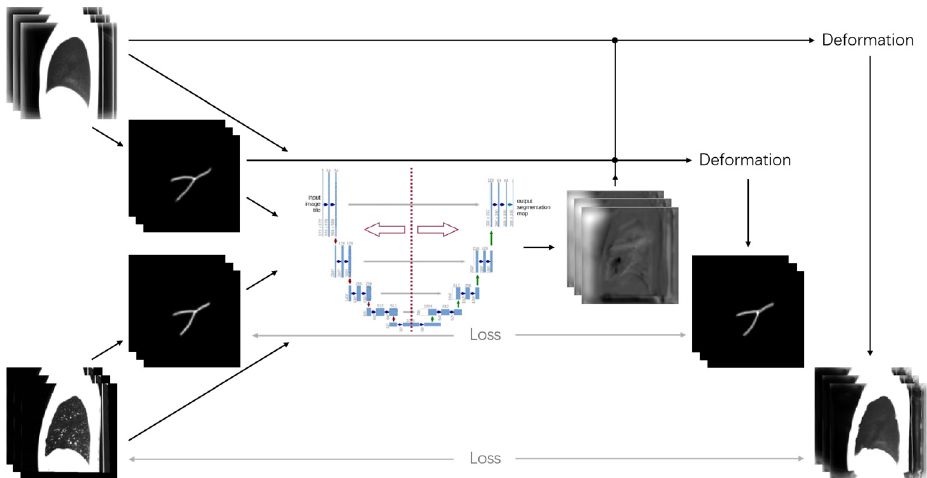
Figure 2. Illustration of the fissure-based registration method.